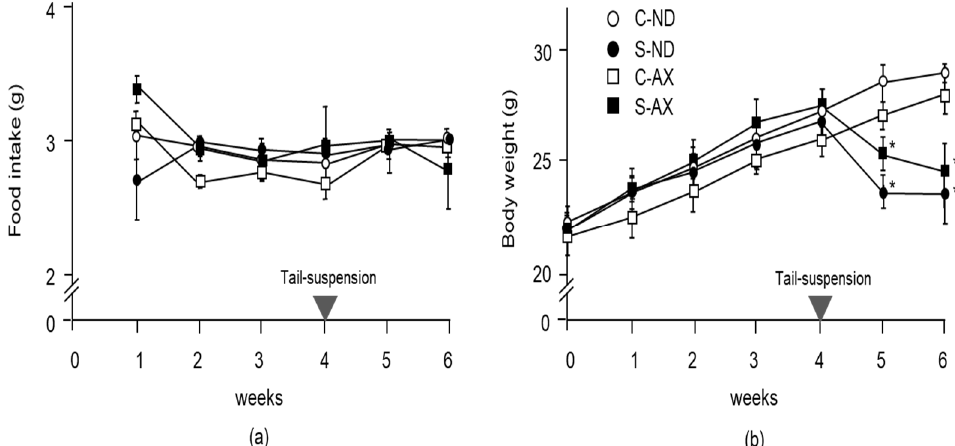
Figure 1. Changes in food intake and body weight with the astaxanthin (AX) diet: ( a ) food intake; ( b ) body weight. Mice were fed an AX or normal diet for 6 weeks. They were subjected to tail suspension at 4 weeks, which continued for 2 weeks (C-ND, n = 6; S-ND, n = 6; C-AX, n = 6; S-AX, n = 6). Data are presented as mean ± S.D. ( n = 6). Statistical analysis was performed by the two-way ANOVA and Tukey test. * p < 0.05, compared with ND. C-ND, control mice fed the normal diet; S-ND, tail-suspension mice fed the normal diet; C-AX, control mice fed the AX diet; and S-AX, tail-suspension mice fed the AX diet. Arrow means the time of tail suspension.